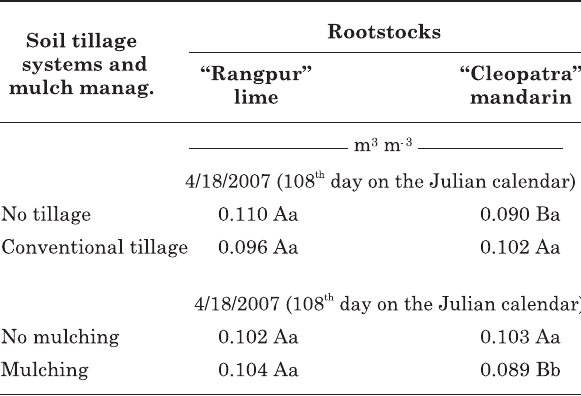
Table 3. Soil water content in the 0–20 cm layer for